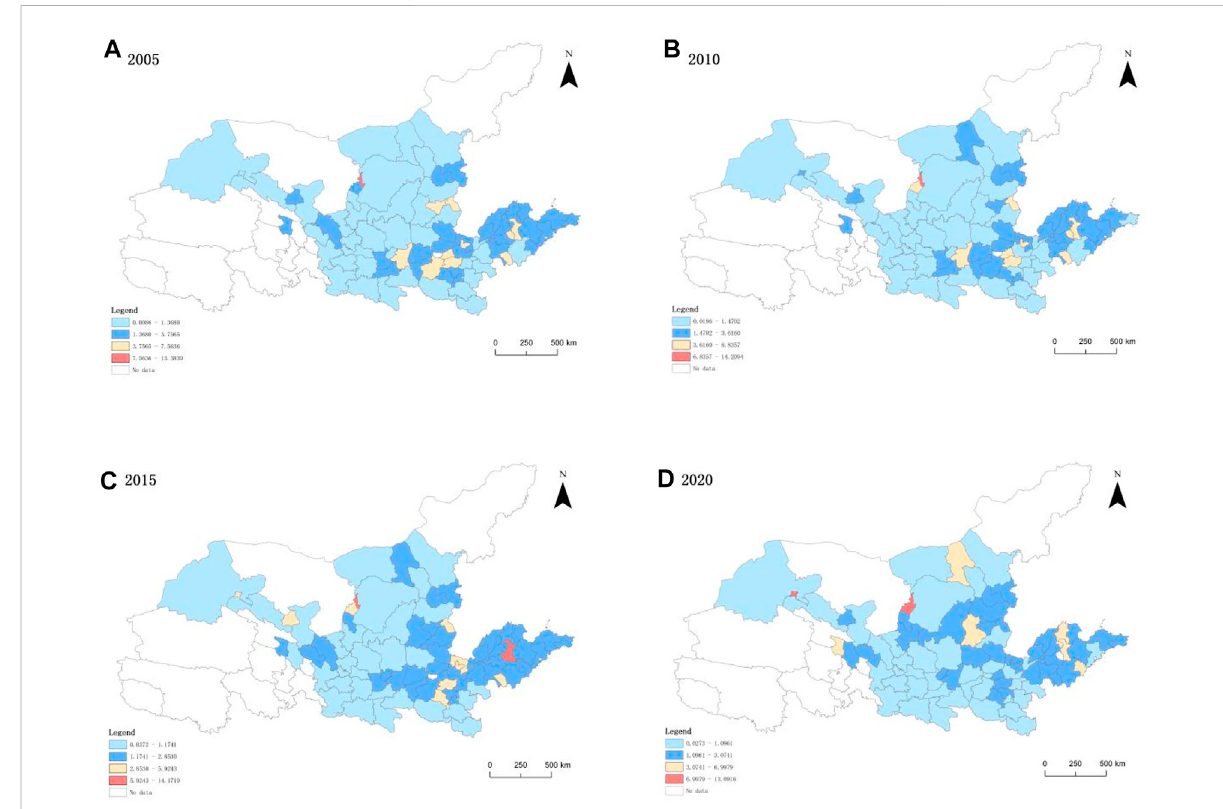
FIGURE 4 Spatial pattern of industrial SO 2 emission agglomeration in the Yellow River Basin in 2005, 2010, 2015,